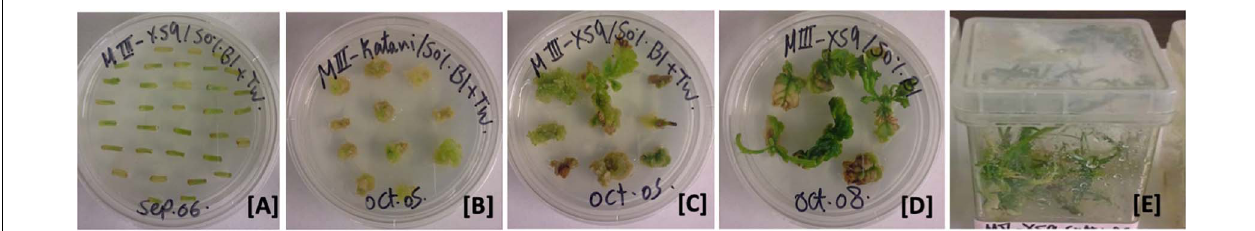
Frontiers in Plant Science |